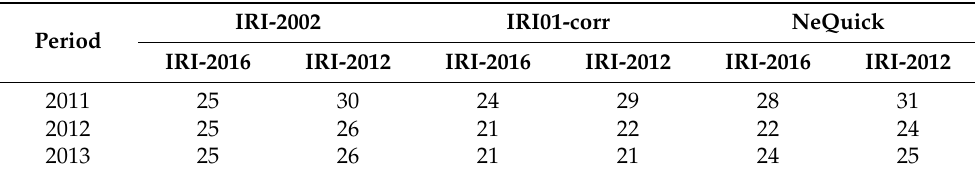
Figure 5. The daily variation of the DVTEC during the quiet period. The IRI-2016 (IRI-2001, IRI01- corr, and NeQuick) are plotted in solid lines and the IRI-2012 (IRI-2001, IRI01-corr, and NeQuick) are plotted in dotted lines. Table 1. The maximum DVTEC values in IRI-2001, IRI01-corr, and NeQuick for IRI-2016 and IRI-2012